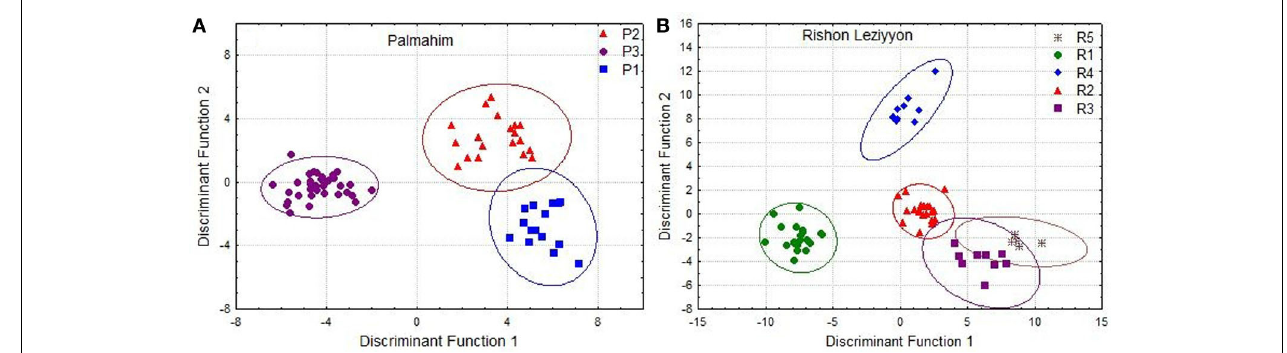
FIGURE 4 | Discriminant analysis based on cuticular hydrocarbons of individuals from Palmahim (A) and Rishon Leziyyon (B) sites. For these analyses we considered all individuals of a specific genetic colony